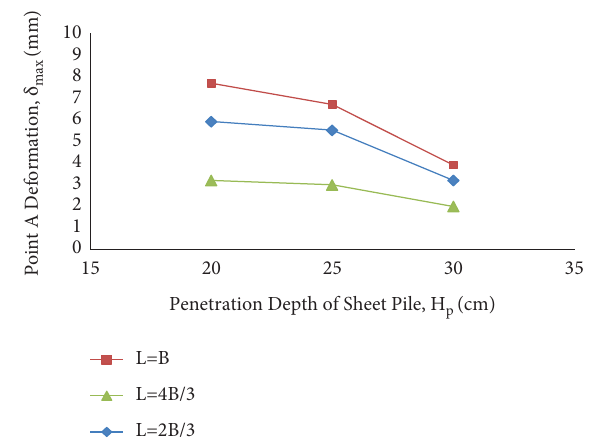
Figure 13: Change of δ max vs. H